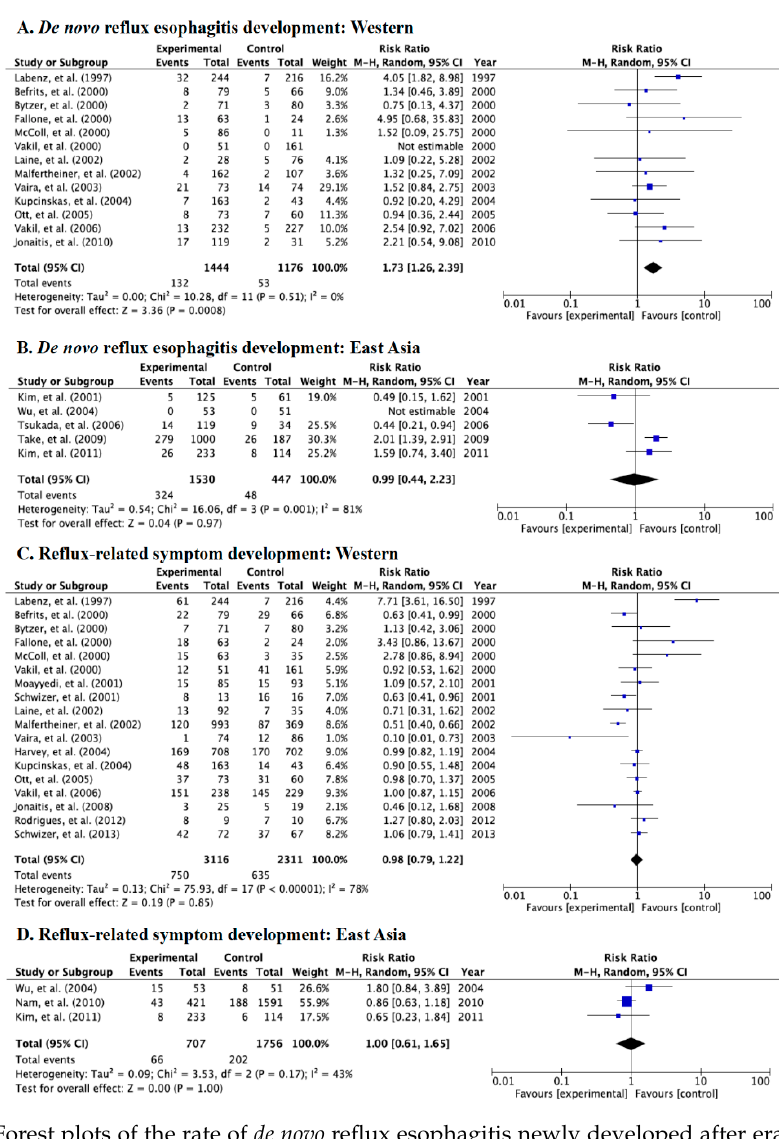
Figure 6. Forest plots of the rate of de novo reflux esophagitis newly developed after eradication in Western populations ( A ) and East Asian populations ( B ) and the rate of patients with reflux-related symptoms after eradication therapy in Western populations ( C ) and in East Asian populations ( D ). Significant differences are seen in the incidence of de novo reflux esophagitis in Western populations, whereas no significant differences are seen in East Asian populations. Abbreviations: CI, confidence interval.